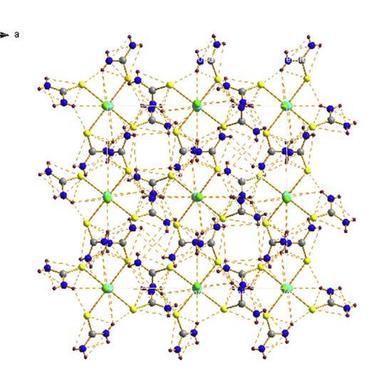
Hydrogen bonds in the structure of tetrakis(thiourea)cobalt chloride crystal.